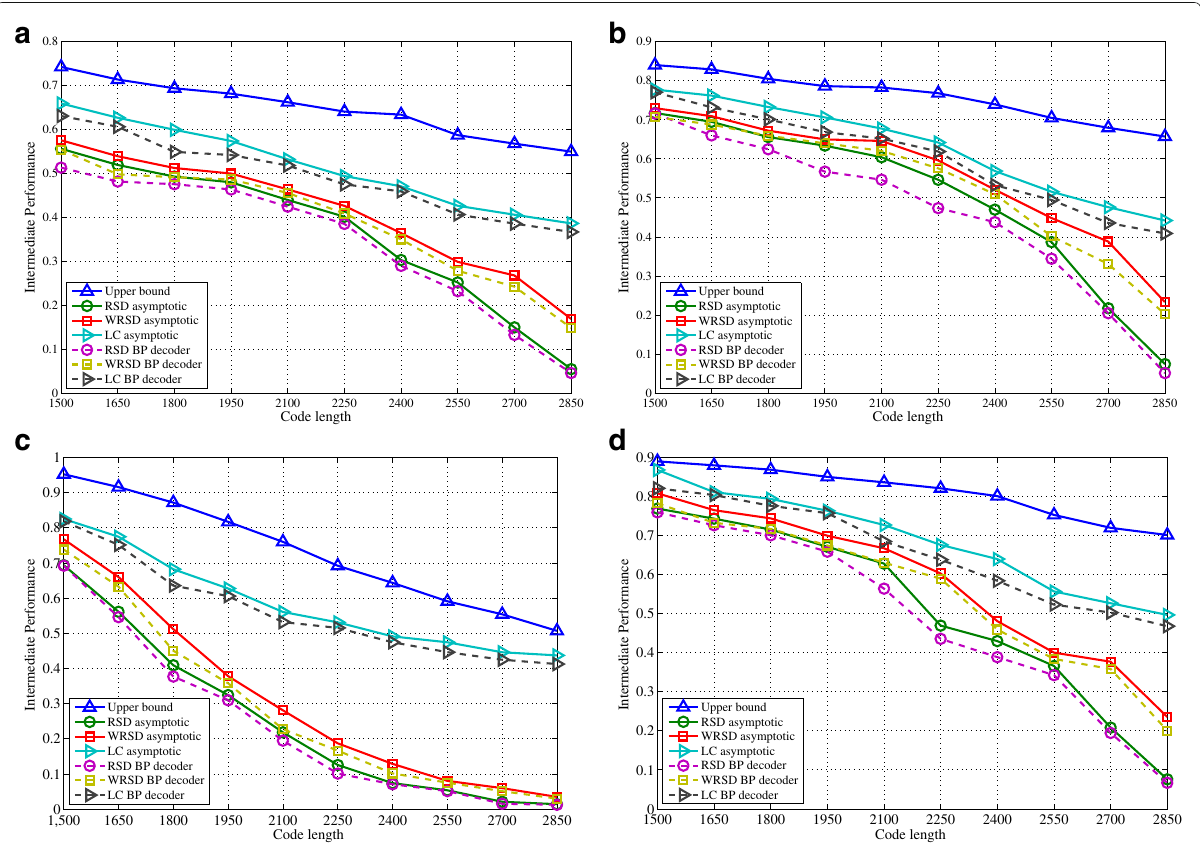
Fig. 5 Intermediate performance for (cid:5) LC ( x ) . Intermediate performance for (cid:5) LC ( x ) compared with RSD and WRSD when the channel lifespan follows exponential distributions and a non-negative Gaussian distributions. The subfigure titles are a 1 /λ = 3000; b 1 /λ = 5000; c μ = 2000 and σ = 400; d μ = 3000 and σ = 1600